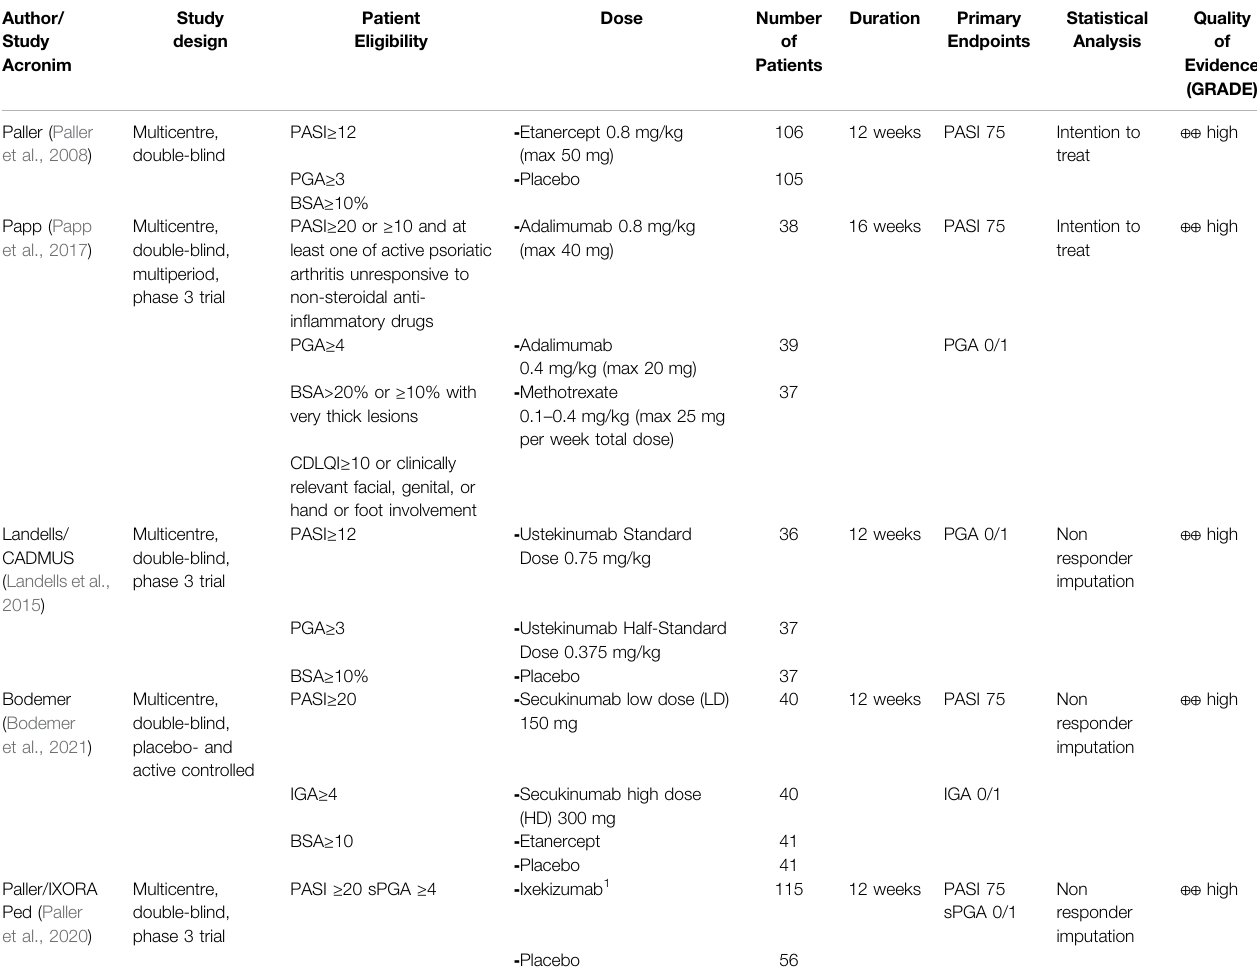
TABLE 2 | Summary of main characteristics of the selected clinical